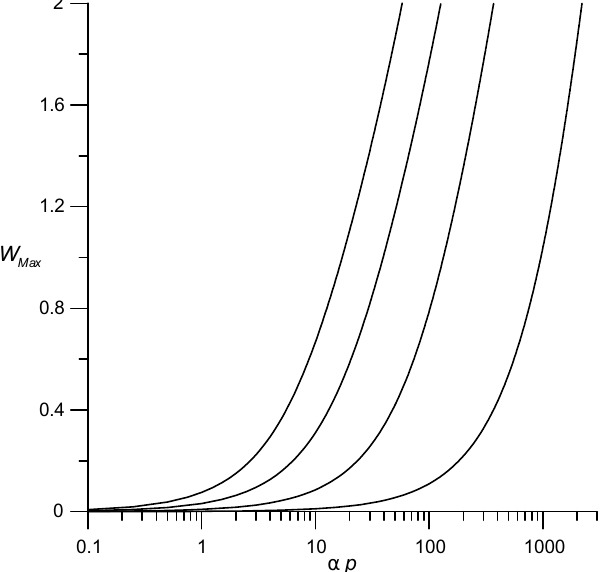
Fig. 4. Variation of the maximum nondimensional deflection W Max with the applied nondimensional load αp for free-clamped plates of inner radii b = 0 . 1 , 0 . 3 , 0 . 5 , and 0 . 7 .